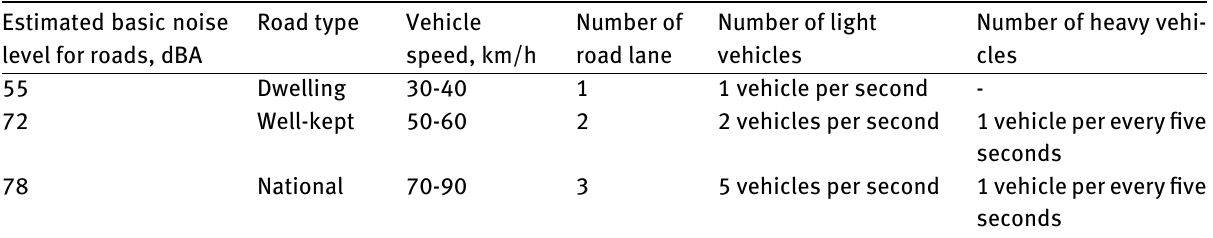
Table 4: Basic noise level for roads. Road types, vehicle speed in km/h, (the least) number of road lane, number of light and heavy vehicles. Time was 11 minutes. No heavy vehicles were assumed for dwelling roads.